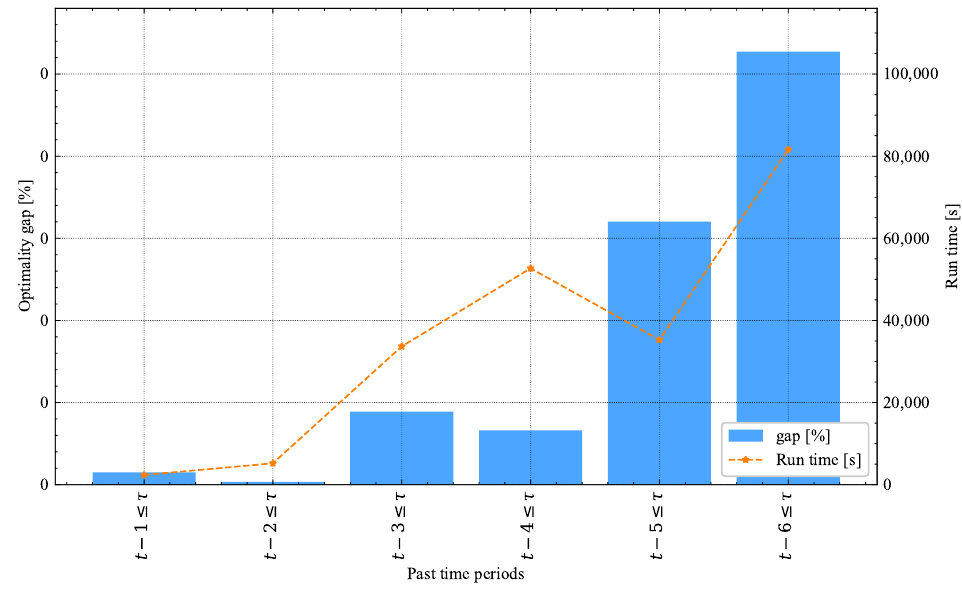
Figure 6. OF value and solution time vs. amount of past time information, 24-bus